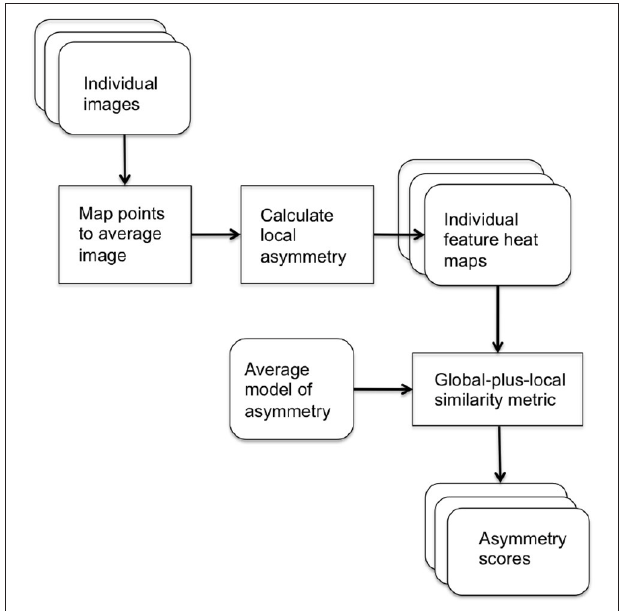
FIGURE 1 | Block diagram of system for assigning asymmetry scores.